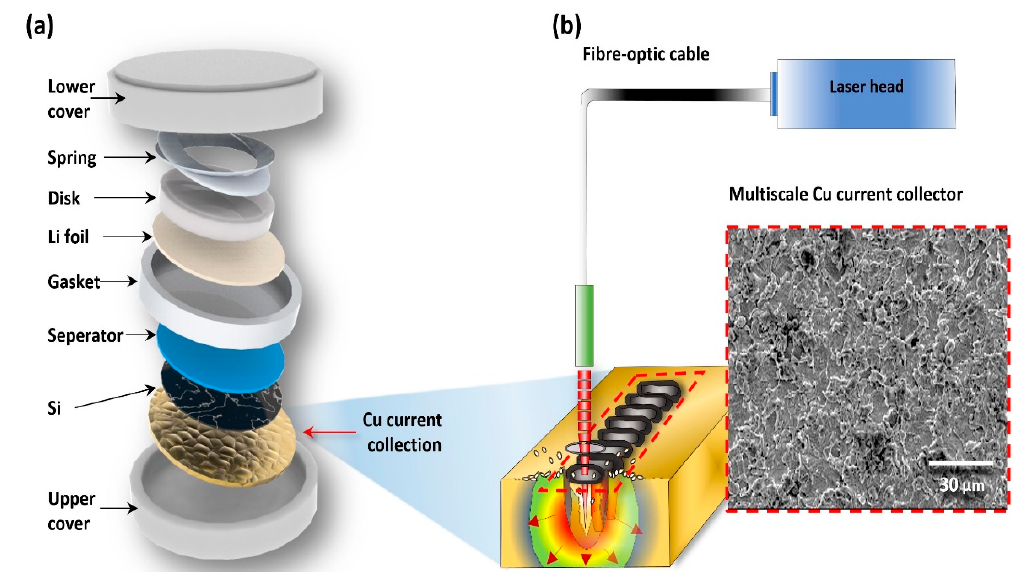
Figure 1. Laser one-step structuring to create a textured surface: ( a ) a typical setup for a coin-type cell battery; ( b ) a schematic diagram of nanosecond laser and SEM images of the Cu surface after laser irradiation.